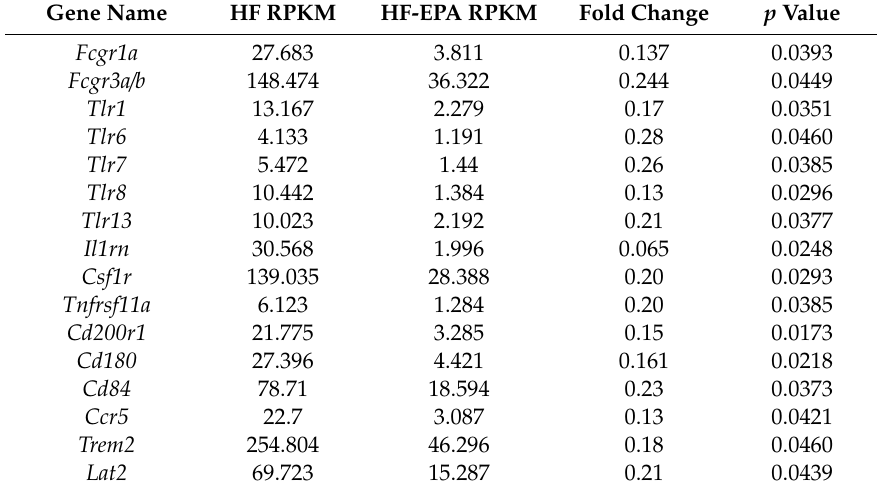
Table 2. Di ff erentially expressed genes data of surface receptors downregulated by EPA in visceral